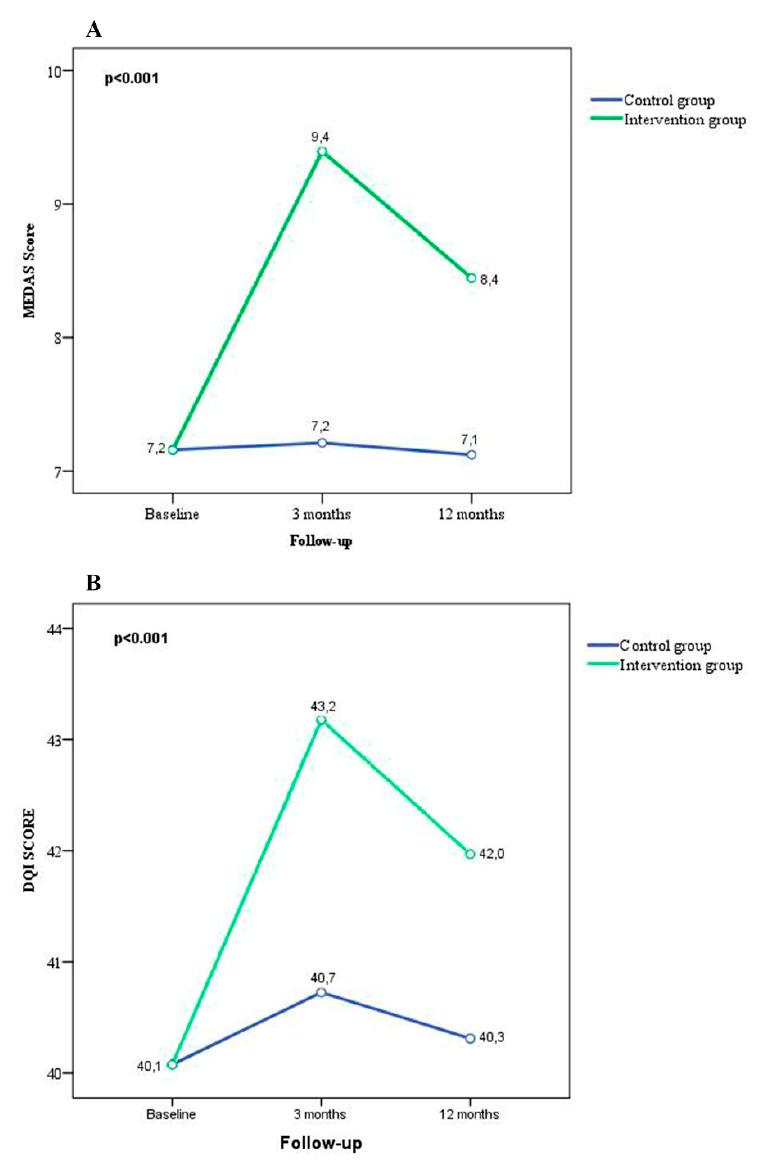
Figure 3. Changes in the MEDAS score and the DQI score tasks in response to the multifactorial intervention. Repeated-measures ANOVA was been performed with adjustment for the baseline visit. MEDAS: Mediterranean Diet Screener; DQI: Diet Quality Index.